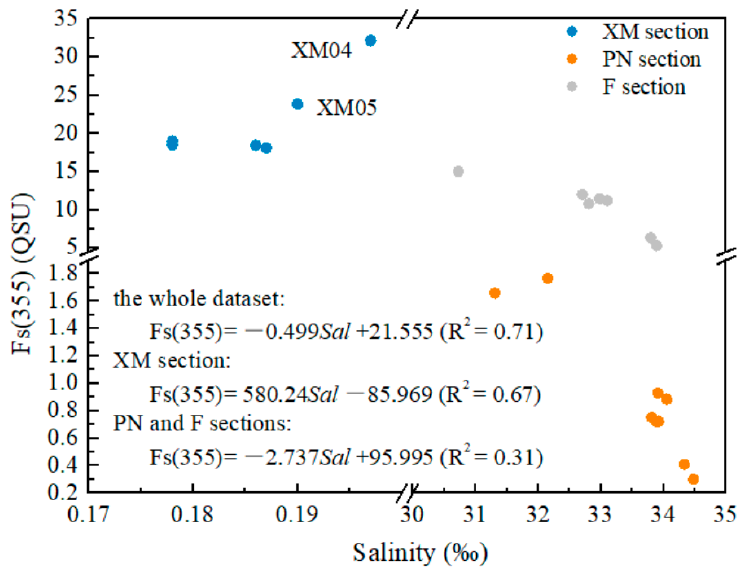
Figure 6. Relationship between salinity and Fs(355) for the datasets of sections PN and F and for the entire dataset.